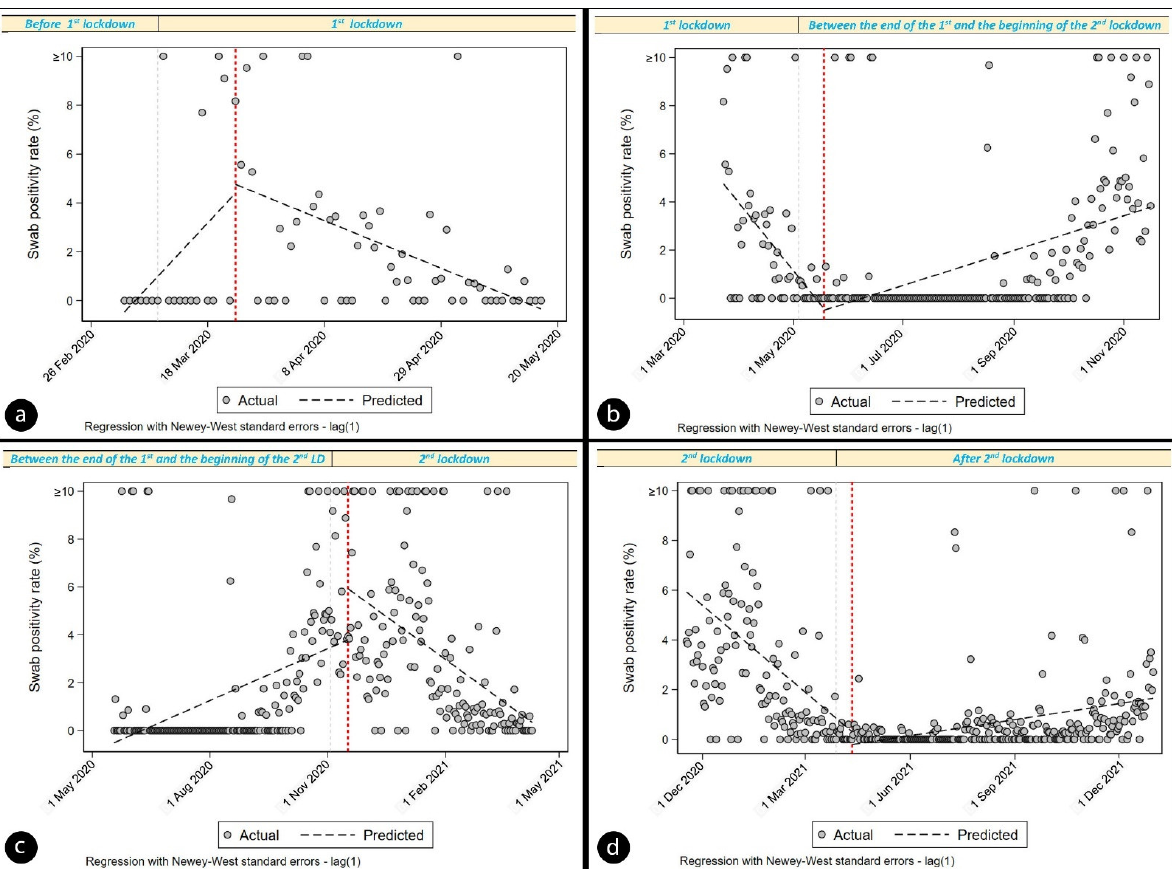
Figure 2. Regression with Newey–West standard errors. The red dotted line represents the intervention point. ( a ) shows postlinear trend regression output from 23 March 2020 (start of 1st lockdown + 14 days) intervention point. ( b ) represents the increase of swab positivity rate after the 14th day after the end of 1st lockdown (18 May 2020); ( c ) displays the decrease of swab positivity rate after the 14th day after start of 2nd lockdown (17 Novem- ber 2020); ( d ) illustrates the increase of swab positivity after the 14th day after the end of 2nd lockdown (11 April 2021) at a rate of 0.007.